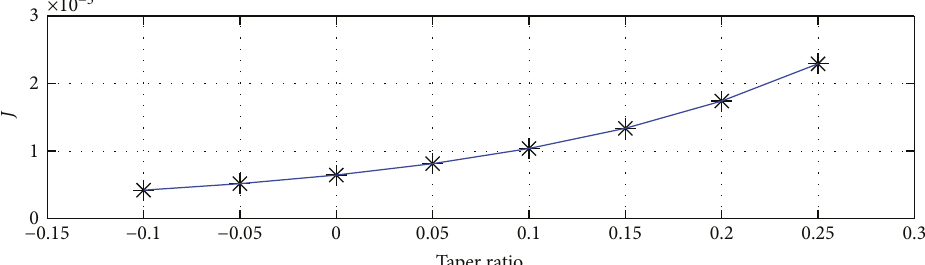
Figure 1: E ff ect of blade taper on control e ff ort for 40-knot straight-and-level fl ight condition (taken from [10]).